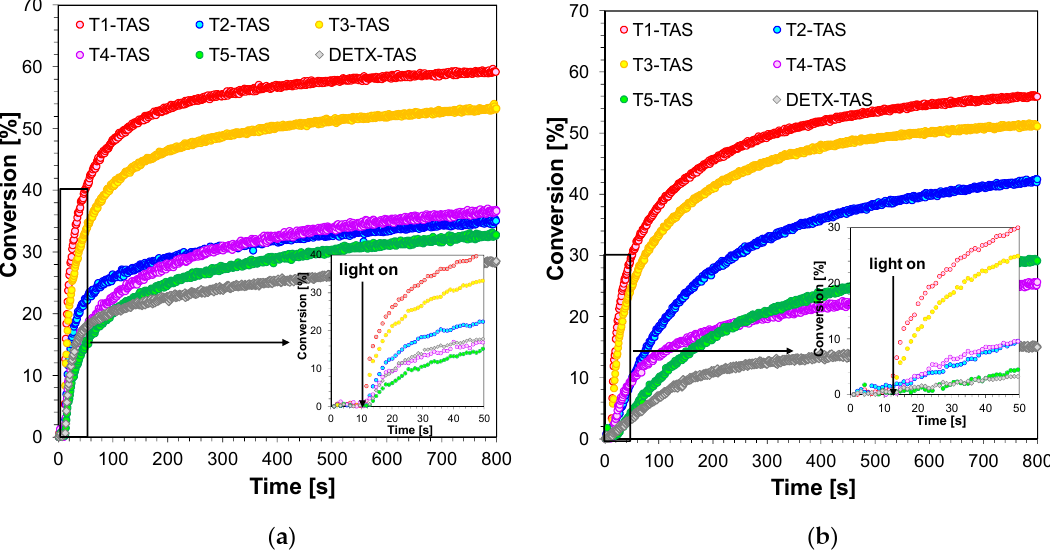
Figure 2. Polymerisation profiles of UVACURE ® 1500 (epoxy function conversion vs. irradiation time) under air in the presence of different photoinitiating systems based on TAS (2% w / w ) and 2,4-diethyl-thioxanthen-9-one derivatives (0.2% w / w ) upon exposure to ( a ) the visible LED@405 nm ( b ) the visible LED@420 nm. The irradiation starts at t = 10 s.